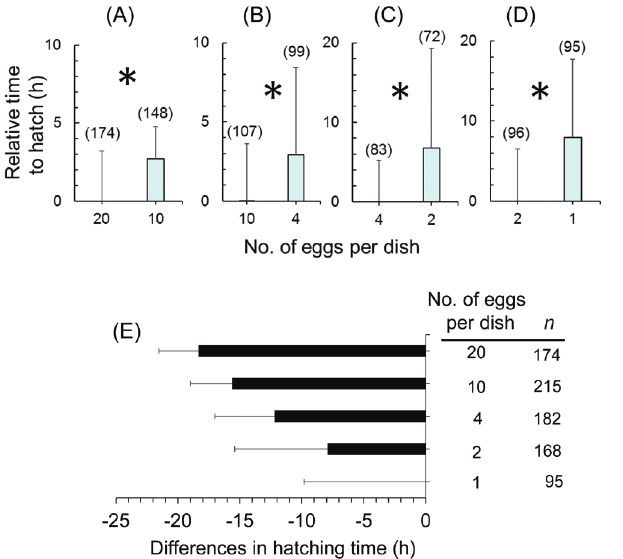
Fig. 6. The hatching times for Locusta migratoria eggs incubated in different mass sizes. In each pair of comparisons, the mean time of hatching for the eggs in the larger mass was designated as 0 h ( A–D ). The numbers in parentheses indicate the number of hatched eggs. Bars indicate one SD. Asterisks indicate a significant difference between the two treatments (p < 0.05; t-test). Differ- ences in hatching time in different masses are shown in ( E ) by designating the mean hatching time for singly kept eggs as 0 h. Horizontal bars indicate one SD.